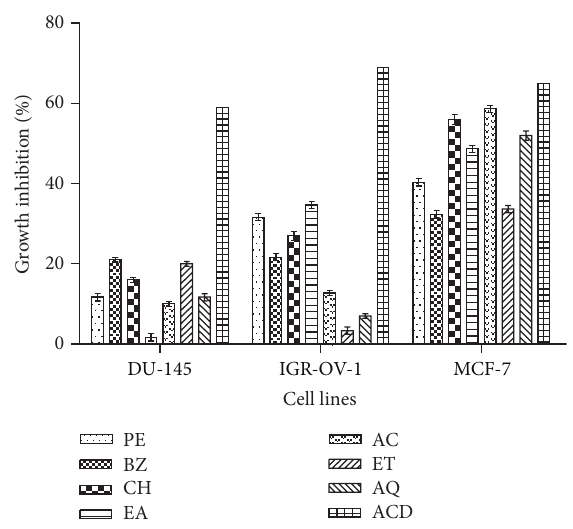
Figure 3: Cytotoxic effect of T. cordifolia extracts against human cancer cell lines. Percentage growth inhibition of cell line was assayed at 100 𝜇 g/mL concentration of extracts using SRB assay as described in Section 2. PE: petroleum ether, BZ: benzene, CH: chloroform, EA: ethyl acetate, AC: acetone, ET: ethanol, and AQ: water. ACD: Anticancer drugs (mitomycin-C (10 𝜇 M) against prostate (DU-145), paclitaxel (10 𝜇 M) against lung (HOP-62) and breast (MCF-7), adriamycin (1 𝜇 M) against ovary (IGR-OV-1), and 5-fluorouracil (20 𝜇 M) against leukemia (THP-1) human cancer cell lines). Data represent mean ± SD of three replicates ( 𝑃 < 0.05